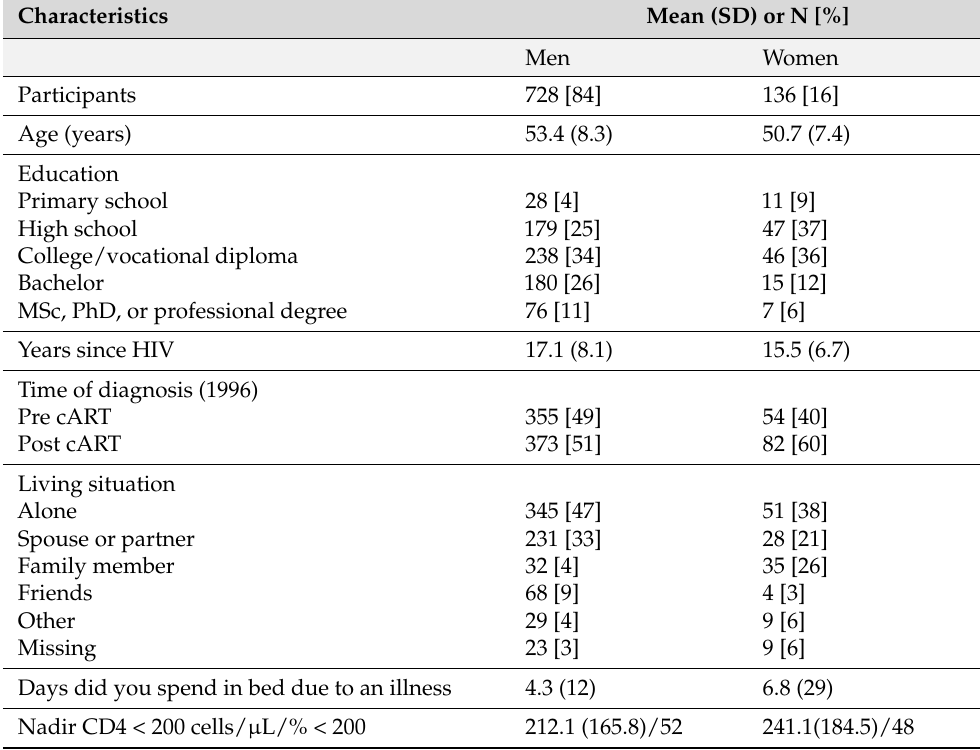
Table 1. Characteristics of the Positive Brain Health Now cohort at study entry (N = 865).